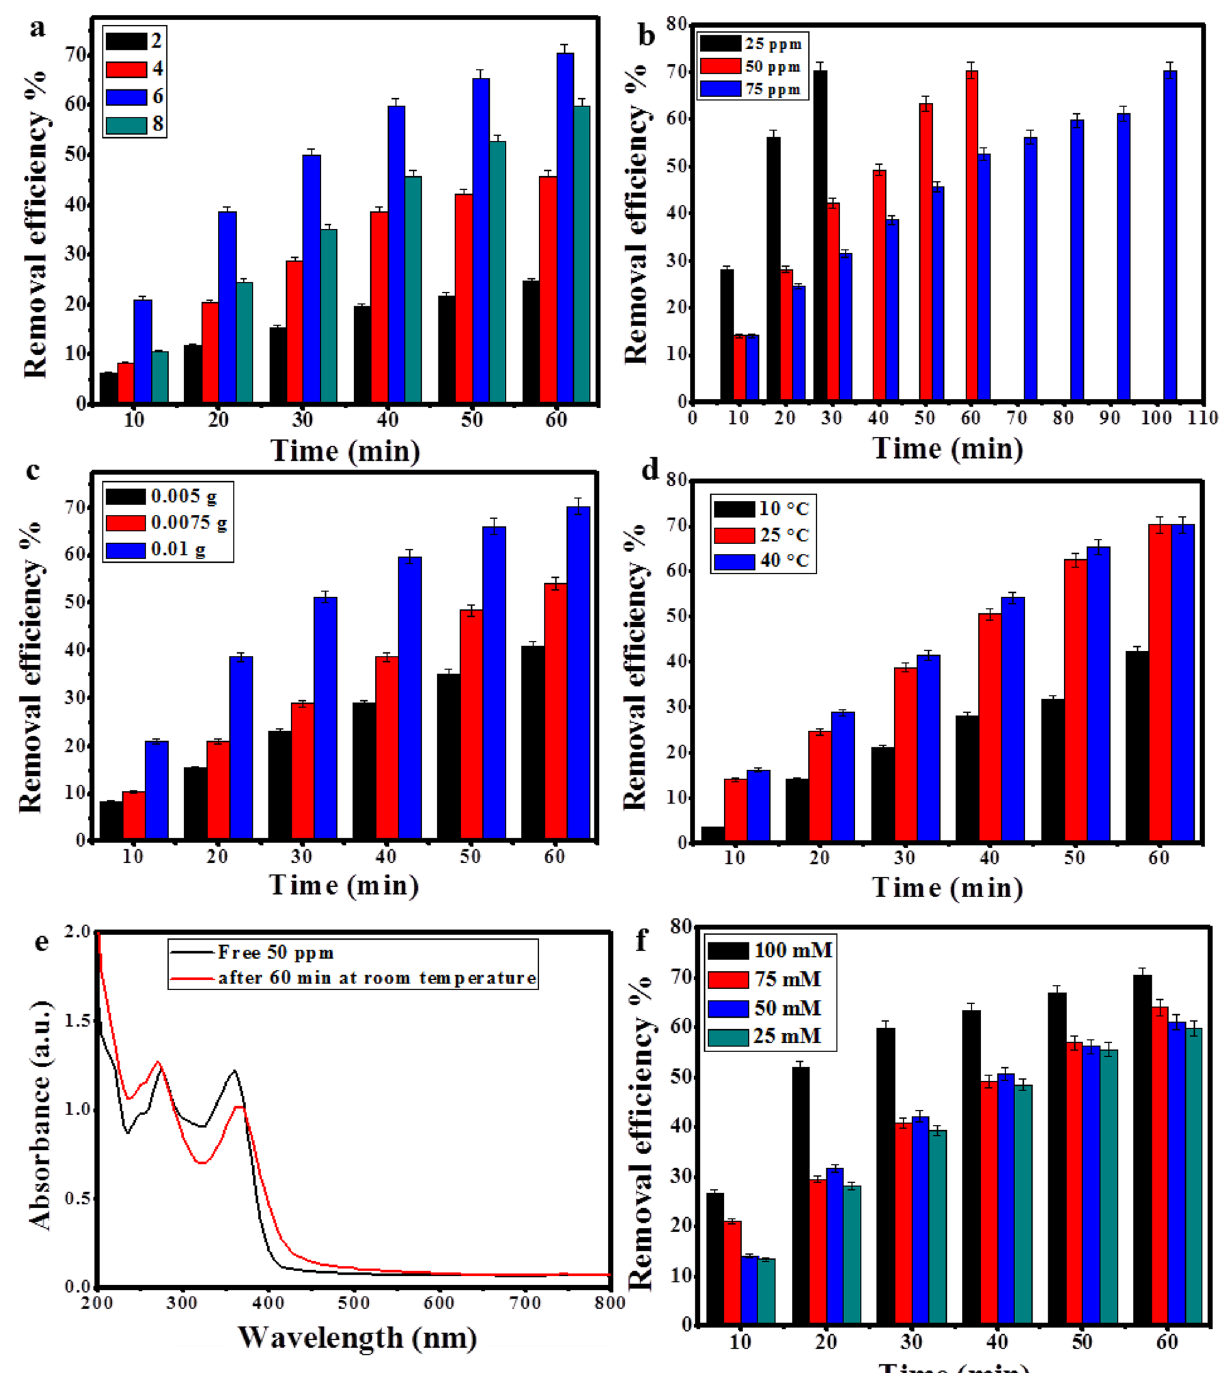
Figure 10. Effect of pH ( a ), initial TC concentration ( b ), Ag/ZnO@BC’s dose ( c ), temperature on the removal efficiency of TC ( d ), Photocatalytic degradation of TC after 60 min using room temperature ( e ), effect of H 2 O 2 concentration on the removal efficiency of TC ( f ), recyclability of Ag/ZnO@BC ( g ), Photocatalytic degradation of TC after 60 min using ZnO/biochar ( h ), and Ag/biochar ( i